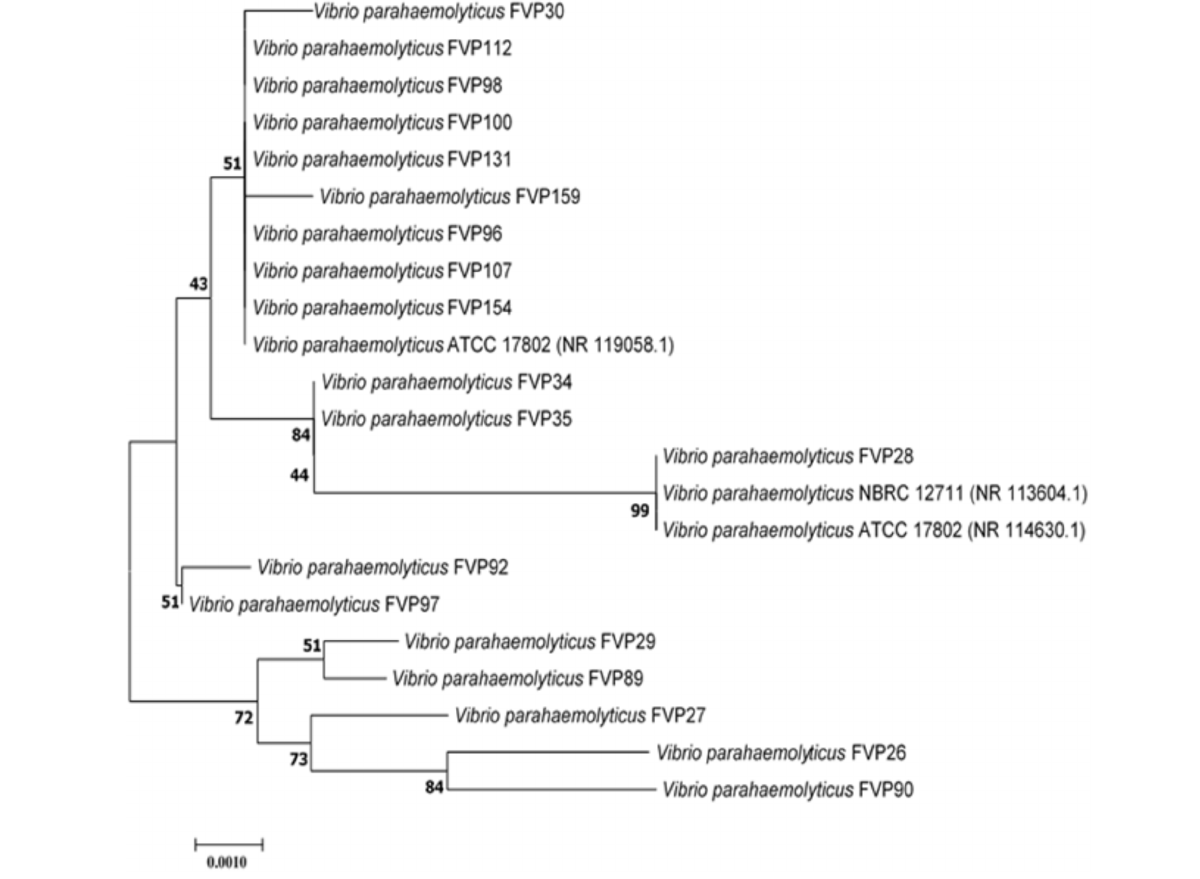
and 53% (87/165) was from supermarket. A total of 96 (58%) of the isolates were isolated from marine fish samples